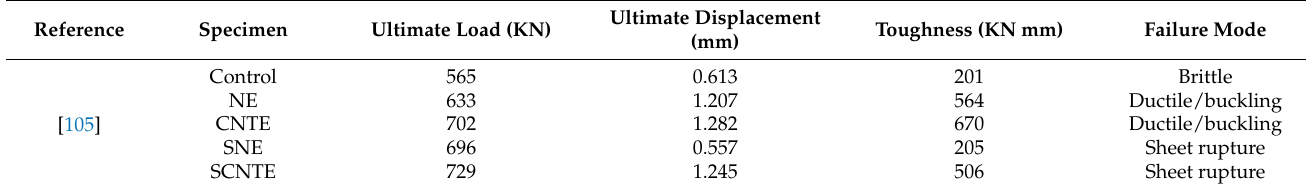
Table 4. Comparison of different types of